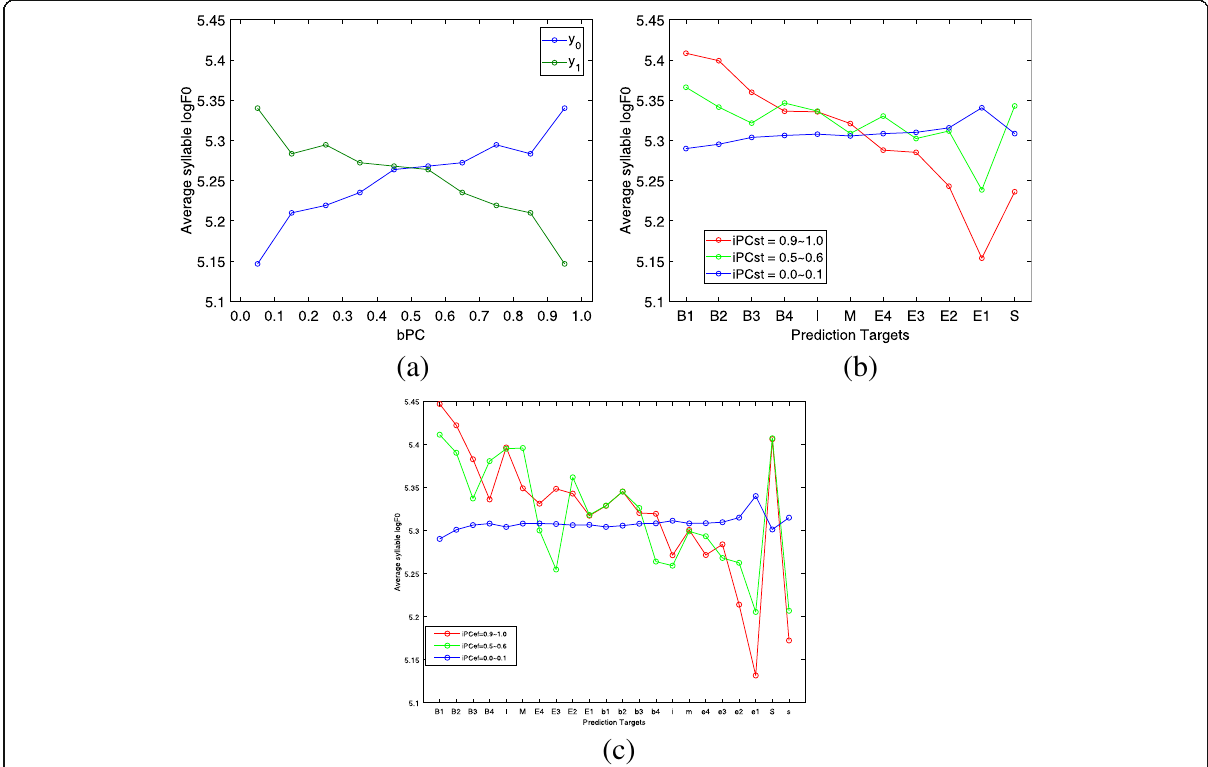
Fig. 5 Average syllable log-F0 corresponding to the prediction targets for a bPC, b iPCst, and c iPCef in different levels of PC